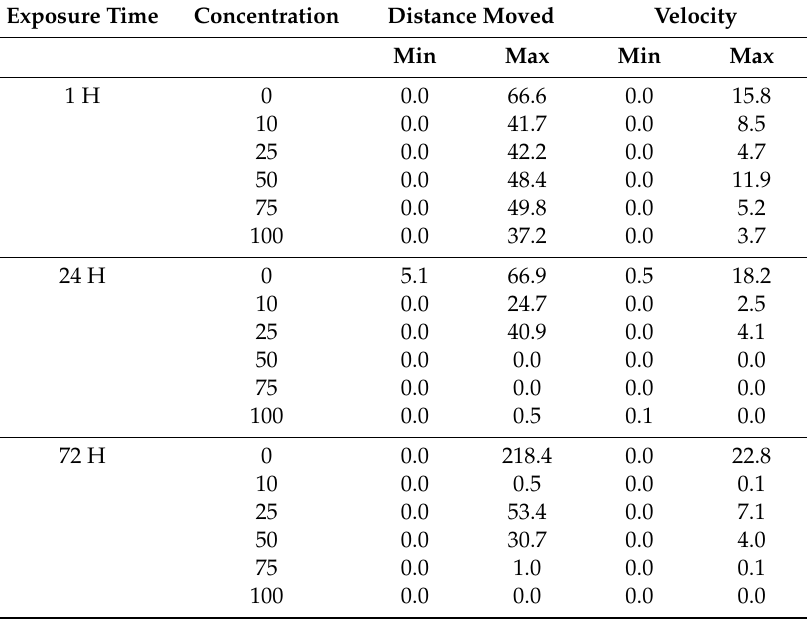
Table 2. Minimum (Min) and maximum (Max) values for total distance moved (in cm) and instantaneous velocity (velocity, cm / min) for R. dominica during 10 min trials after 1, 24, and 72 h of exposure to the combination treatment of deltamethrin + methoprene + piperonyl butoxide synergist, with a total of n = 15 individuals tested per treatment combination. Exposure Time Concentration Distance